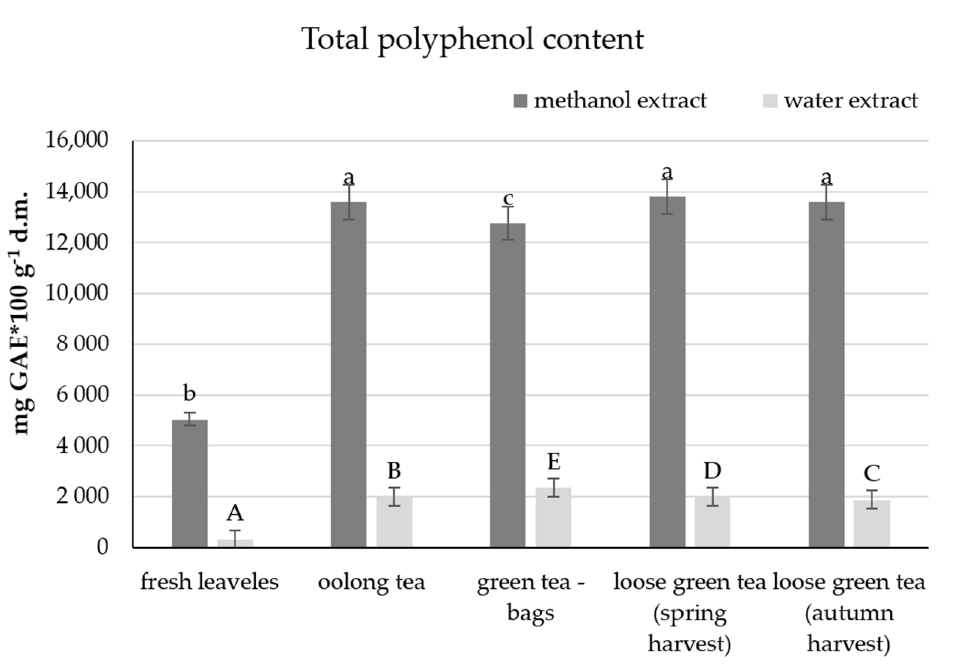
Figure 1. Total polyphenol content in the leaves of the tea plant and various types of tea. The same letter a, b, c indicates no statistically significant differences between the mathanol extracts, and A, B, C—between the water extracts of the analyzed teas.